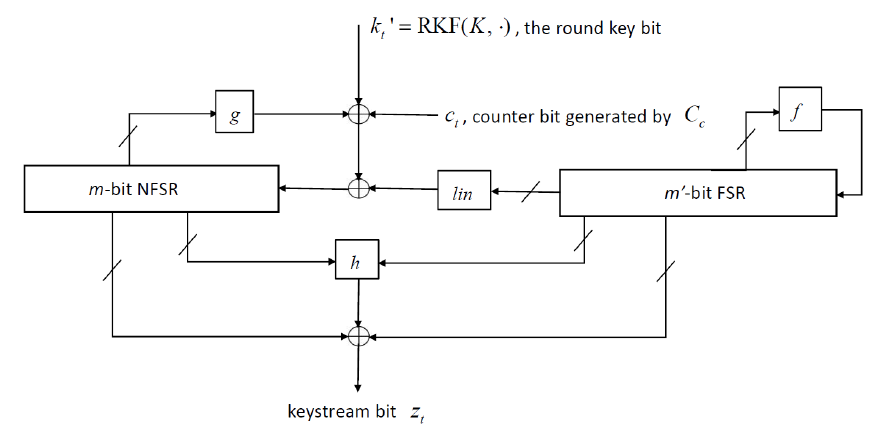
Figure 2: The generic model for the Grain-like small state stream